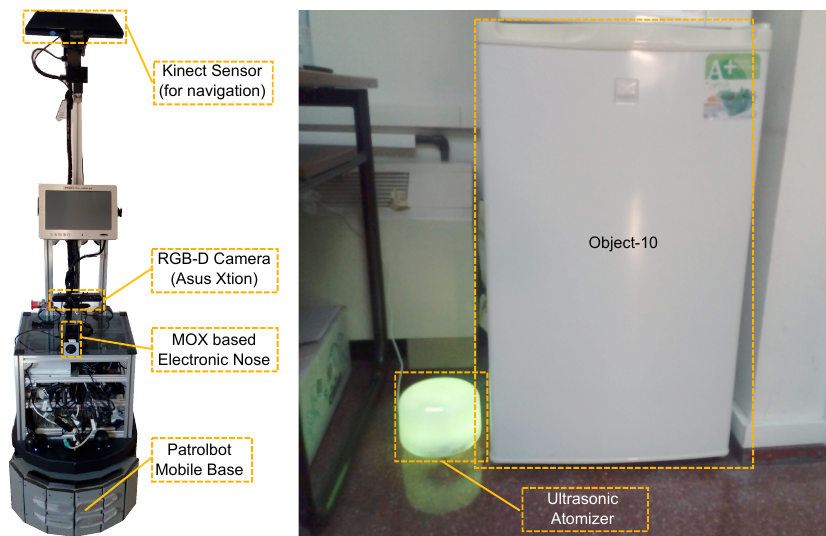
Figure 6. ( Left ) picture of the mobile robot employed during the real experiments. Besides the standard sensors used for navigation (2D lasers and Kinect), the robot was equipped with an additional RGB-D camera to perform object recognition, and a MOX-based e-nose [38] for gas detection and classification. ( Right ) photo of the ultrasonic atomizer releasing a mixture of water and ethanol next to the fridge ( Object-10 ).